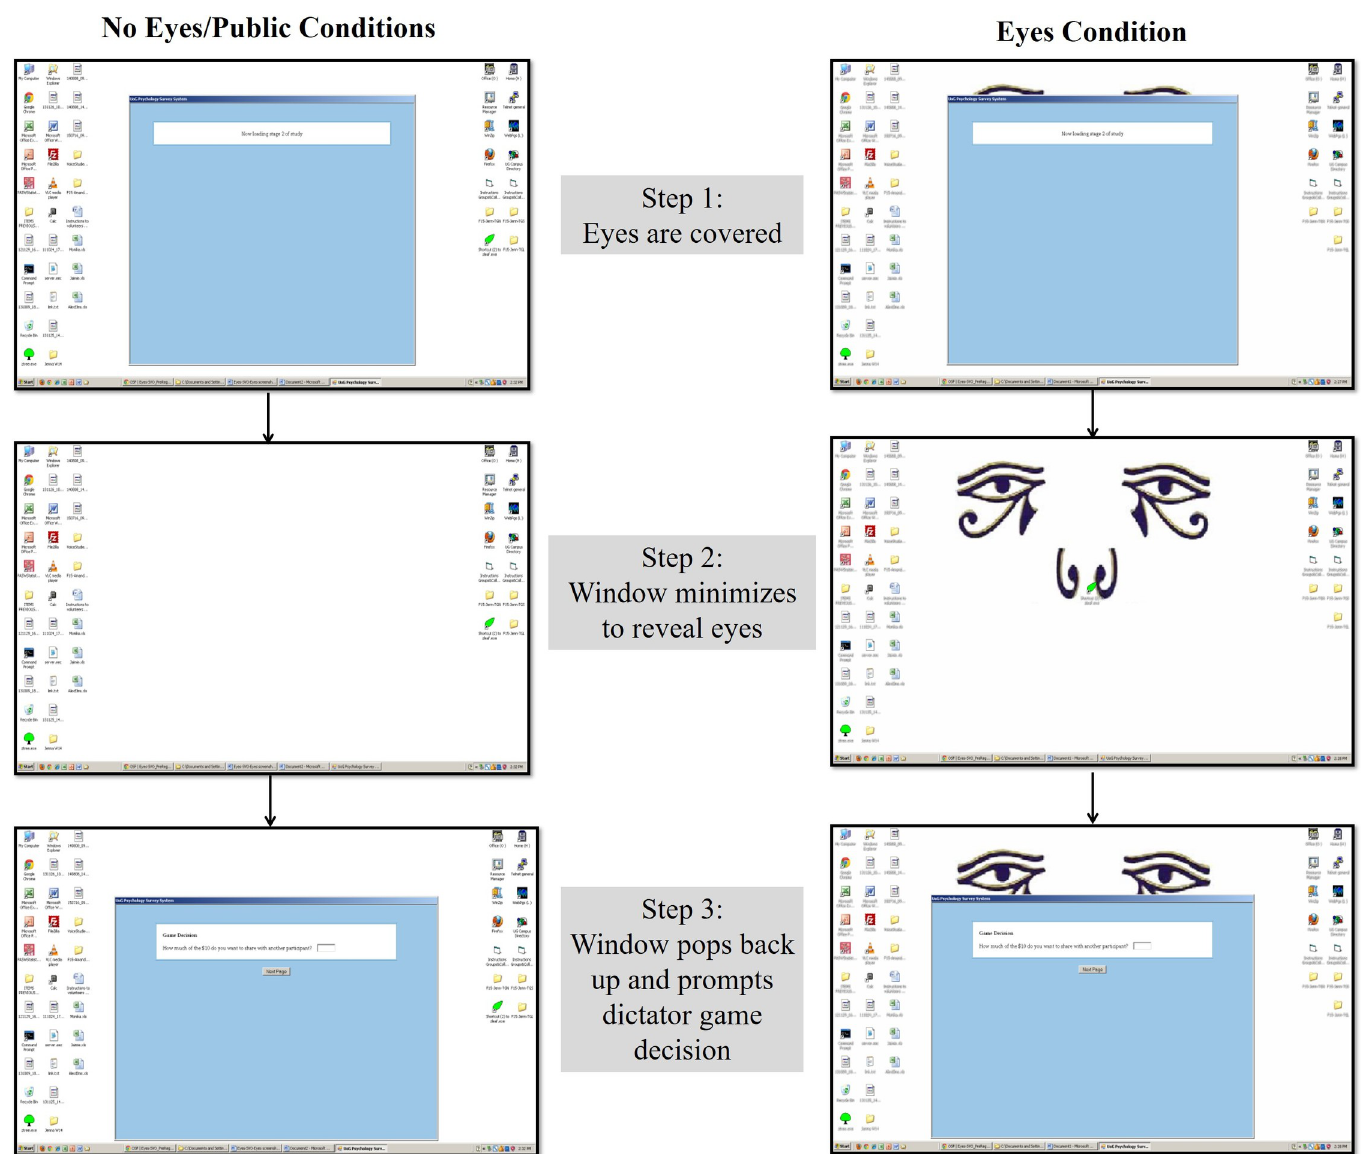
Fig 1. Participant view during the dictator game decision, by